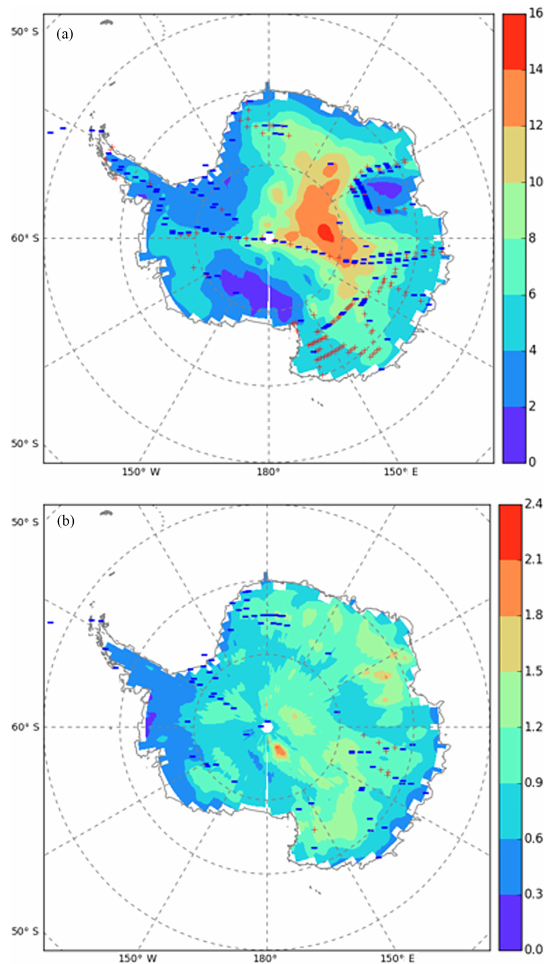
Figure 6. Maps displaying model–data comparisons for d time- averaged (in ‰, a ) values and inter-annual standard deviations (in ‰, b ). Backgrounds correspond to ECHAM5-wiso simulations over the period 1979–2013, while signs correspond to the model– data comparison. For the time-averaged values, the comparison con- sists of calculating the model–data differences. Red “ + ” symbols indicate a positive model–data difference, while blue “ − ” symbols correspond to a negative model–data difference. For the inter-annual standard deviation, the comparison consists of calculating the ratio of the simulated value to the corresponding grid point data. Red “ + ” symbols indicate a ratio higher than 1, while blue “ − ” symbols correspond to a model / data ratio lower than